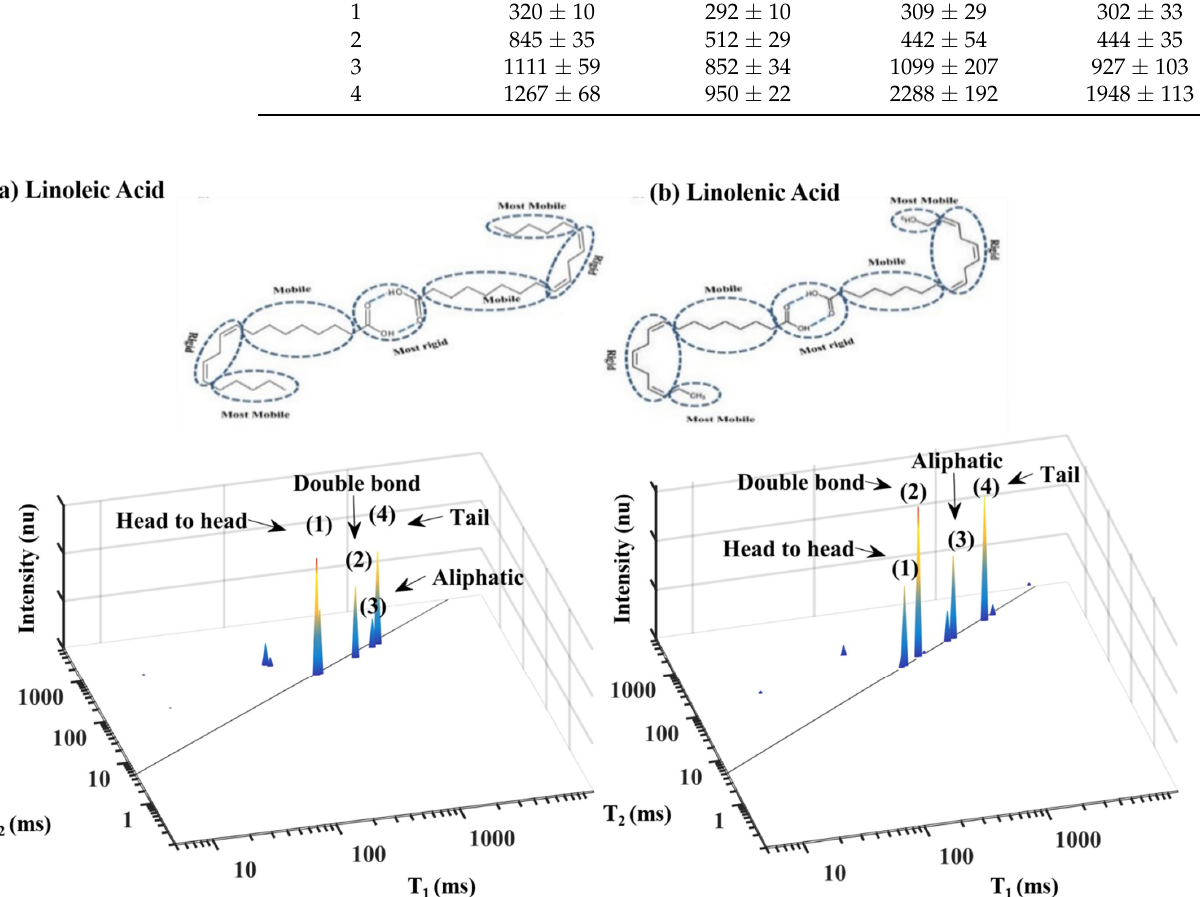
Figure 7. Dimer structure and segmental rigidity-mobility characterization of PUFA. ( a ) Linoleic acid (18:2) and ( b ) linolenic acid (18:3). 1 H LF NMR TD sensor 2D T 1 -T 2 graphic mapping and peak assignment is presented in the lower Table 1 for each of the two PUFAs. Reprinted with permission from ref. [27]. Copyright 2019